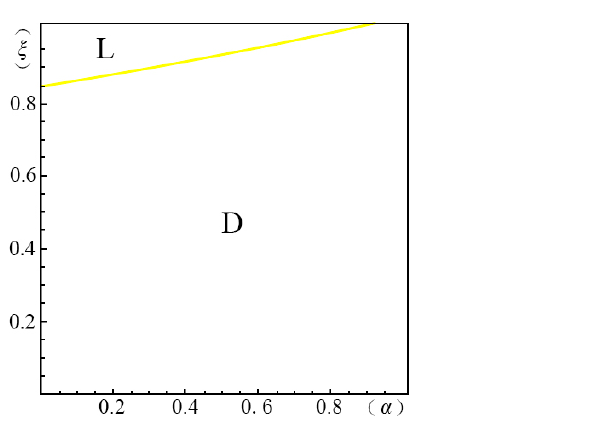
− p 1 A > p 1 A + kg − p (cid:3408) (cid:3043) (cid:3117)(cid:3250) (cid:3397)(cid:1863)(cid:1859) (cid:2879)(cid:3043) when p 2 A when (cid:3043) (cid:3118)(cid:3250) (cid:2879)(cid:3043) (cid:3117)(cid:3250) . Figure 3. Comparison of the four strategies given δ = 1 2 λσδ Q − 1 σδ Q ( 1 − λ ) (cid:3097)(cid:3083)(cid:3018)(cid:4666)(cid:2869)(cid:2879)(cid:3090)(cid:4667) (cid:2870) (cid:3090)(cid:3097)(cid:3083)(cid:3018)(cid:2879)(cid:2869)